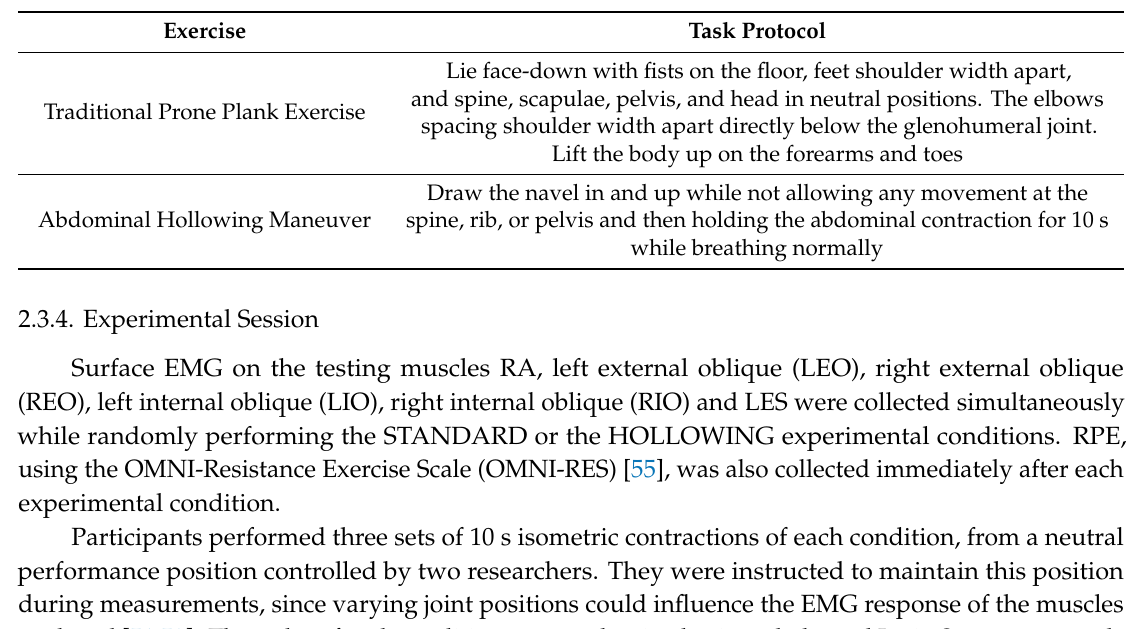
Table 1. Description of the AHM and the prone plank